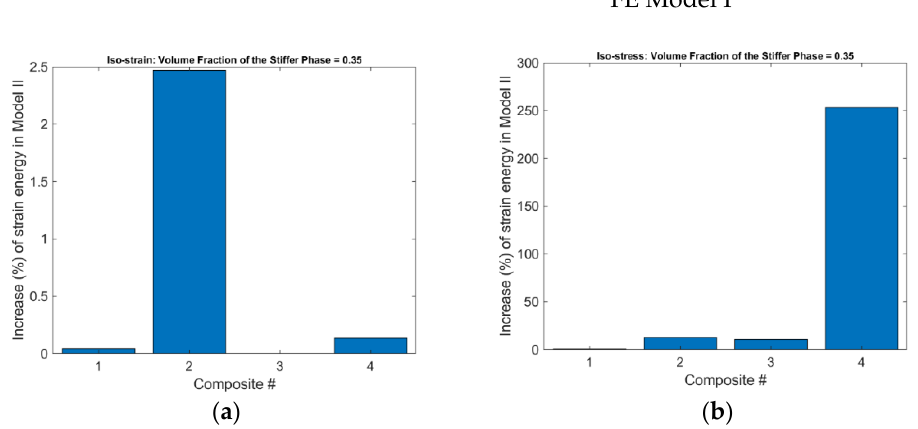
Figure 5. Increase (%) in strain energy in FE Model II compared with FE Model I to achieve the same deformation in the loading direction under ( a ) the iso-strain, and ( b ) the iso-stress conditions.